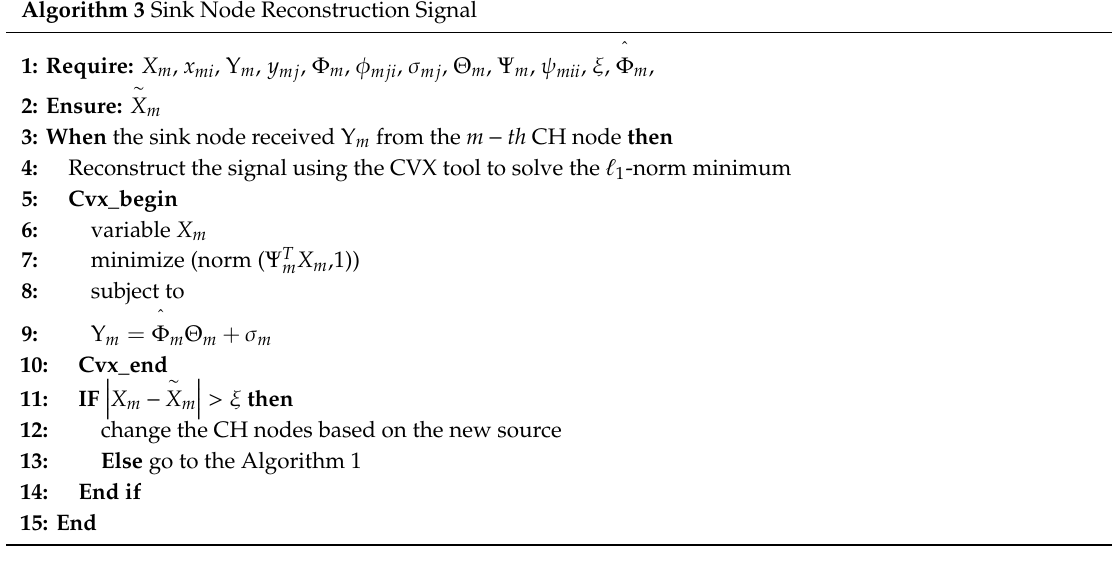
Algorithm 3 Sink Node Reconstruction